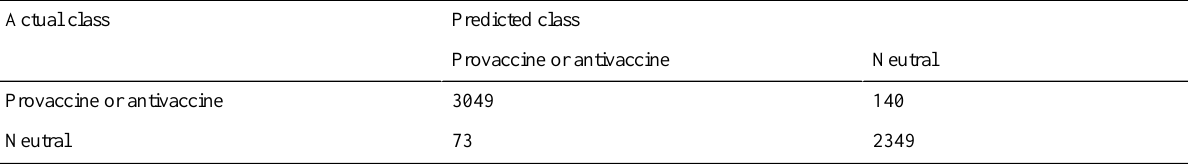
Table 3. Confusion matrix for the binary classification of tweets.